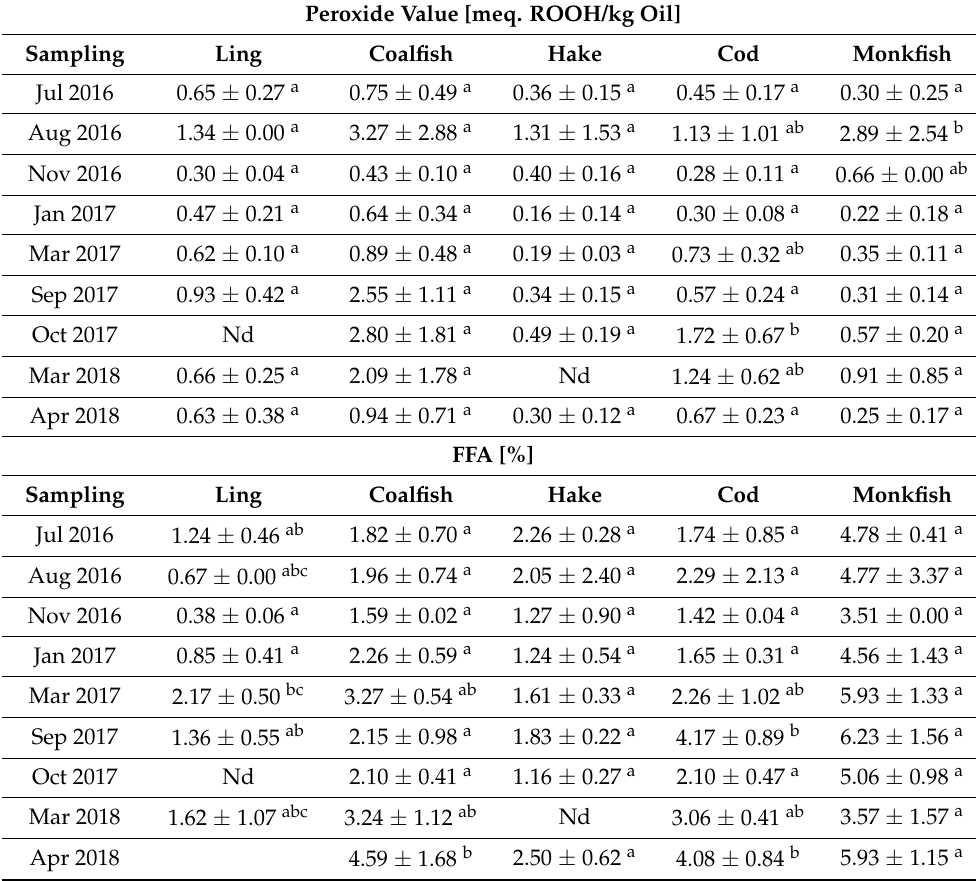
Table 8. Peroxide values and free fatty acid content in fish livers sampled at different time points. Peroxide Value [meq. ROOH/kg Oil]